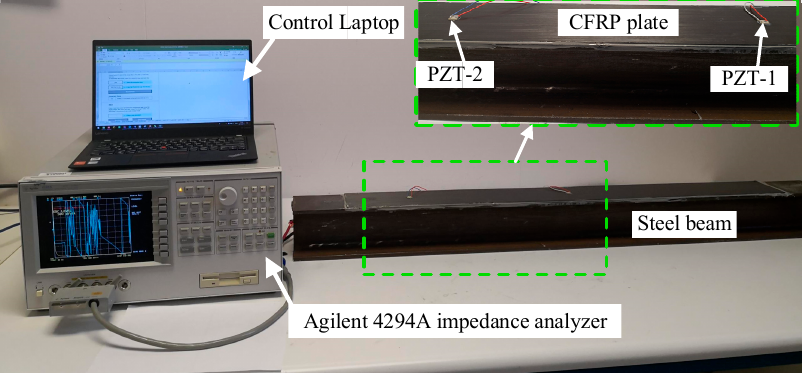
Figure 5. Experimental setup and PZT patches attached to the host structure.